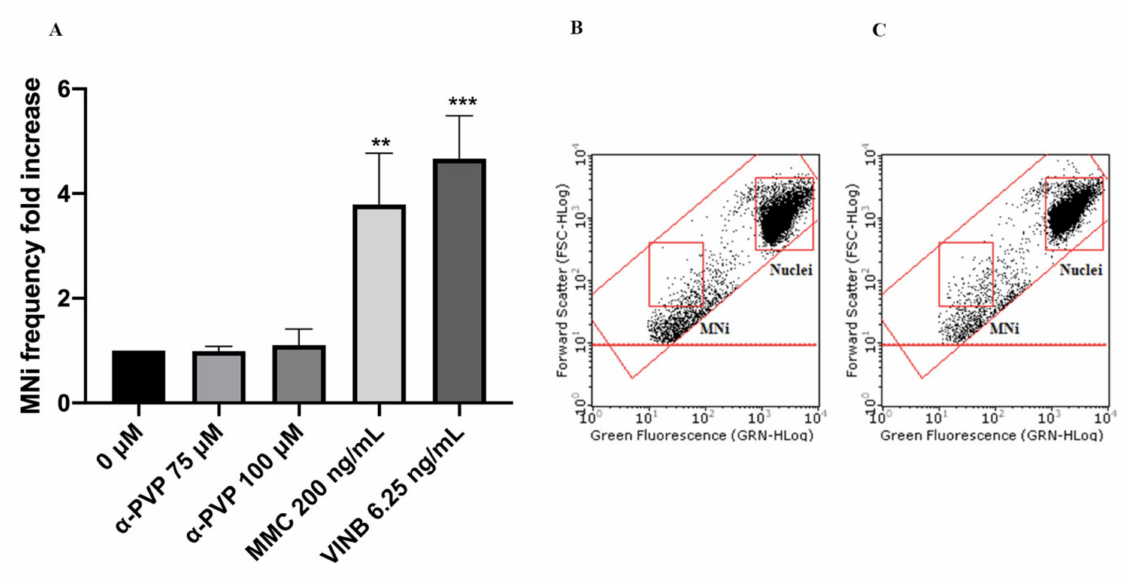
Figure 4. MNi frequency fold increase on TK6 cells after 26 h treatment with α -PVP at the indicated concentrations compared to the negative control [0 µ M] and to positive controls [MMC and VINB] ( A ), plot of nuclei and MNi in the negative control ( B ) and in 100 µ M α -PVP -treated cultures ( C ). Each bar represents the mean ± SEM of five independent experiments. Data were analyzed using repeated ANOVA followed by Bonferroni post-test. ** p < 0.01 vs. 0 µ M; *** p < 0.001 vs. 0 µ M.